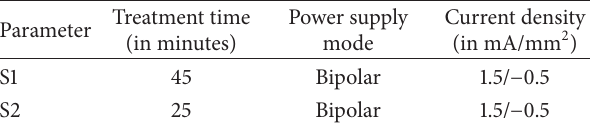
Table 2: Parameters for the PEO preparation of the samples. Treatment time Power supply Parameter (in minutes)